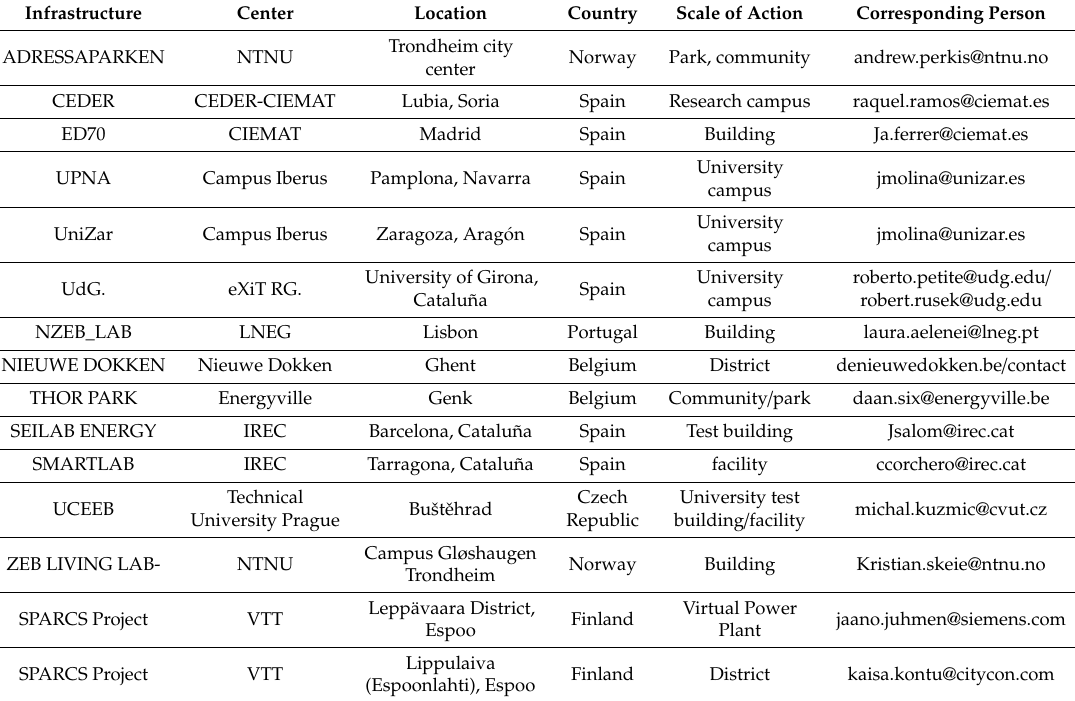
Table 1. Name, center, location, country, scale of action, and contact person defined for the sixteen cases submitted in the first